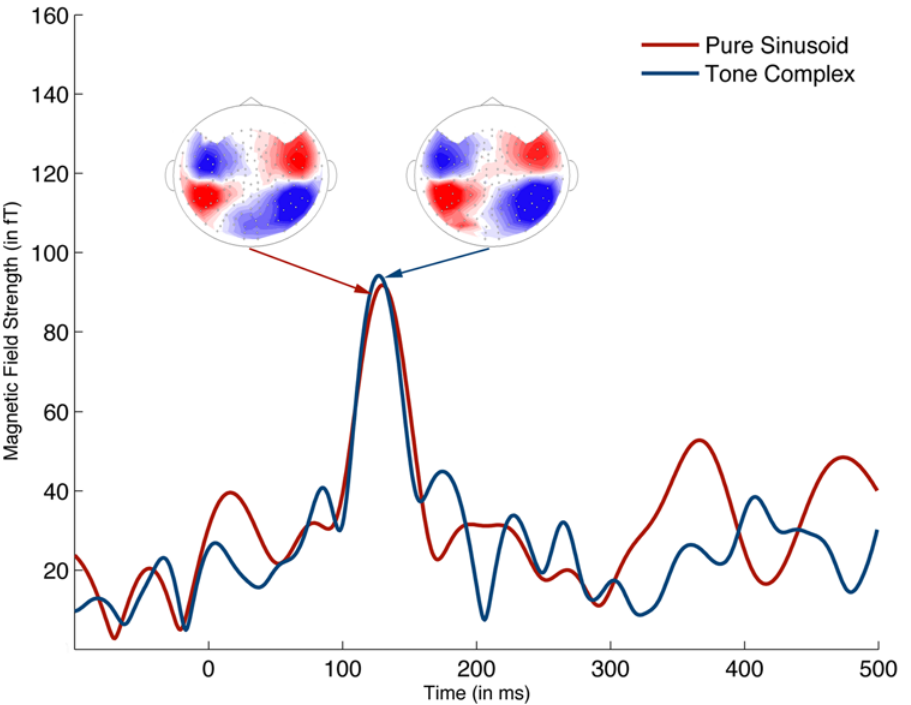
Figure 2. Comparison of the MEG waveforms to a pure sinusoid (in this case, 600 Hz) and tone complex with the corresponding inferred fundamental (in this case, 12-18-24) for a representative subject. Data is the RMS from 10 channels (five sink, five source) in the left hemisphere. The peak around 100 ms post-onset of the target (0 ms represents the onset of the target) is the M100. The peak latency of the M100 to the pure sinusoid and its corresponding tone complex were closely matched. The head-models represent the magnetic field contours for the M100. The red regions represent the source of the dipole and the blue regions represent the sink of the dipole.